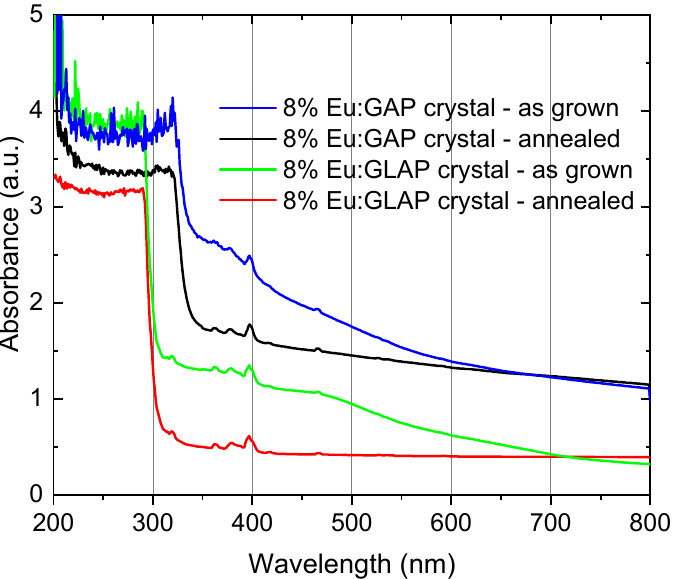
Figure 4. Absorbance spectra of the as-grown and annealed Eu:GAP and Eu:GLAP crystals (after double-side polishing to 1.0 mm thickness).